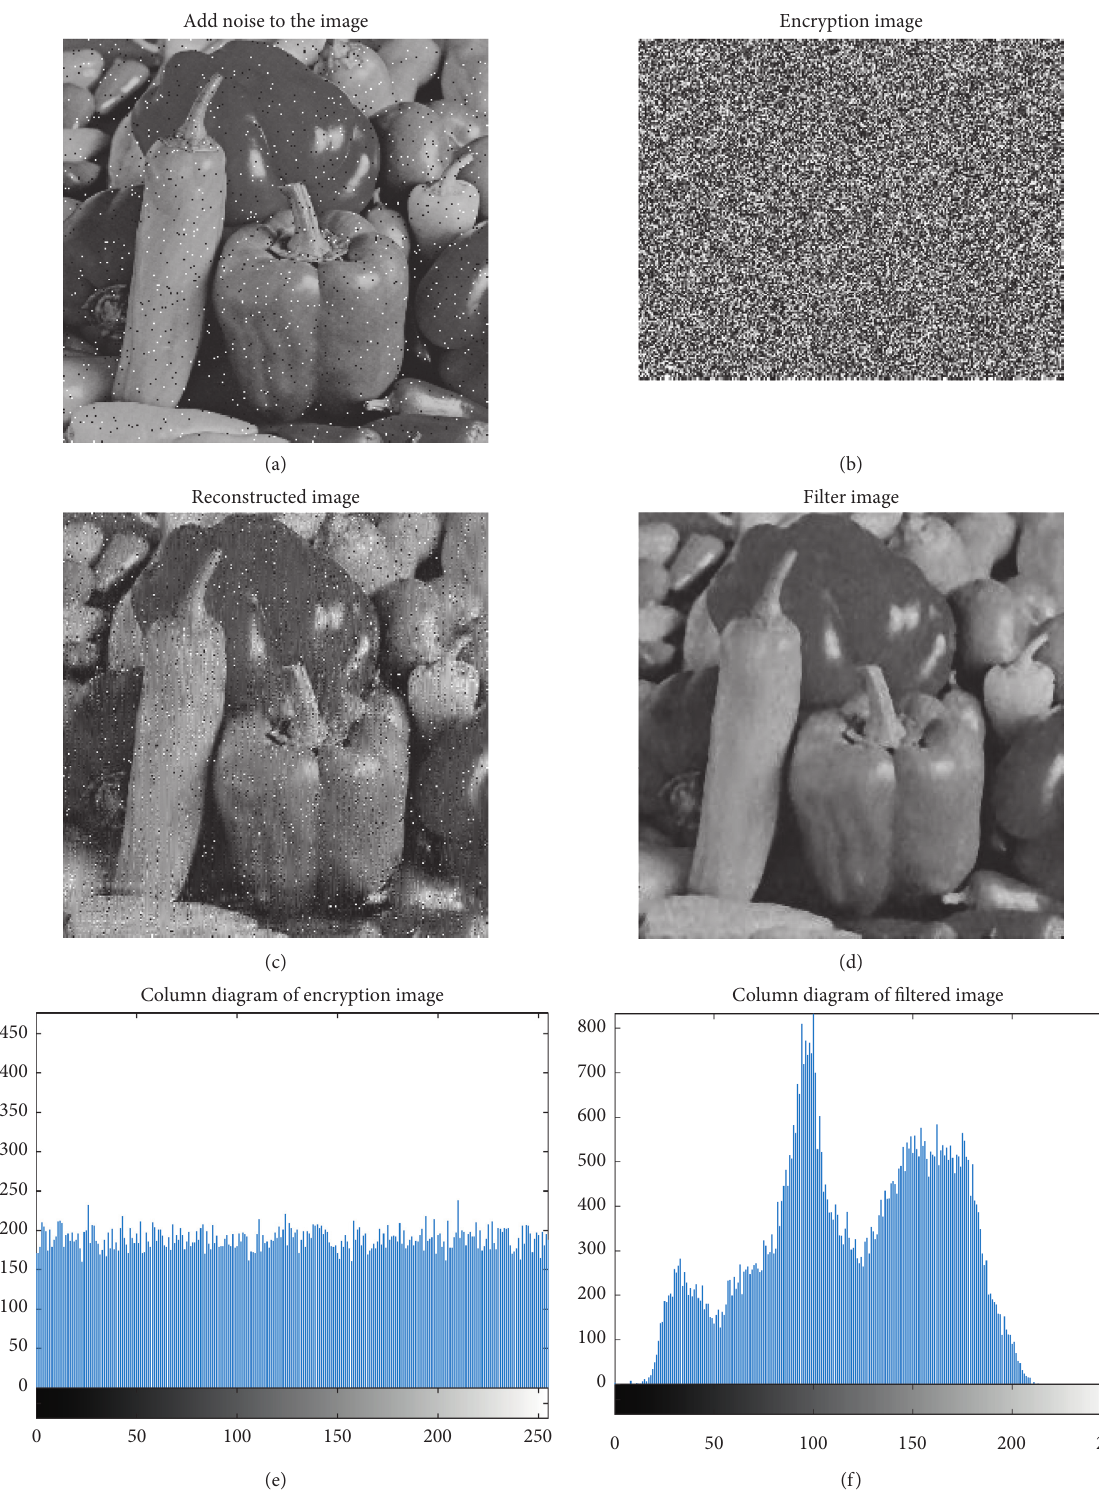
Figure 8: Encryption and reconstruction of noisy images: (a) image with noise, (b) cipher image, (c) reconstructed image, (d) filtered image, (e) histogram of cipher text image, and (f) histogram of filtered